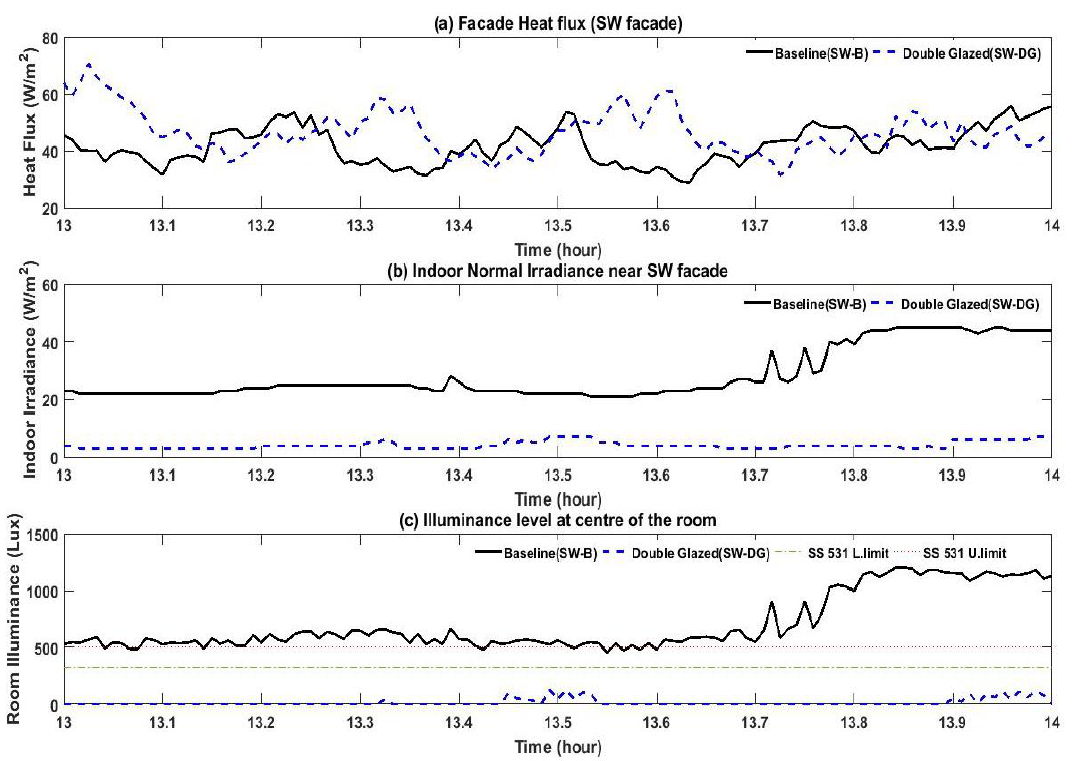
Figure 6. Comparative plots before and after retrofit double glazing of NW façade: ( a ) Façade heat Figure 5. Comparative plots before and after retrofit double glazing of SW façade: ( a ) Façade heat flux; ( b ) indoor normal irradiance; ( c ) illuminance level at room center. flux; ( b ) indoor normal irradiance; ( c ) illuminance level at room center. Table 6. Air-con power consumption and energy savings after retrofit double-glazing installation (measured values from test